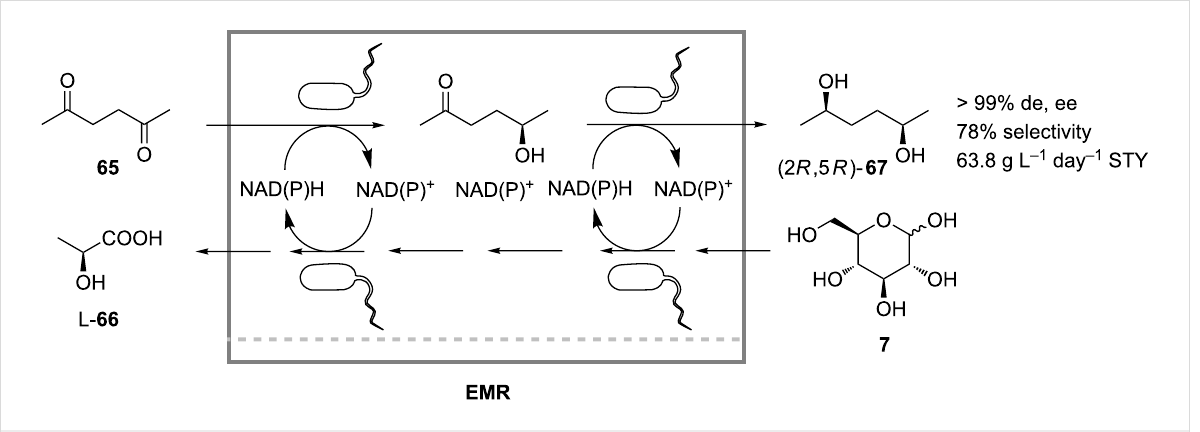
Scheme 21: Continuous production of (2 R ,5 R )-hexanediol ( 67 ) in an enzyme membrane reactor containing whole cells of Lactobacillus kefir [47].